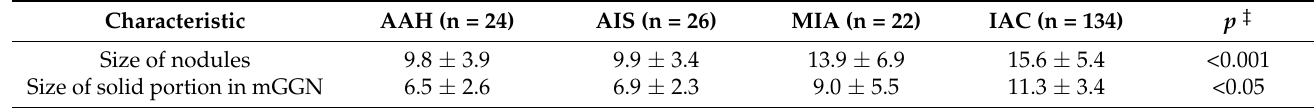
Table 3. Size of nodules and solid portion in each malignant group.